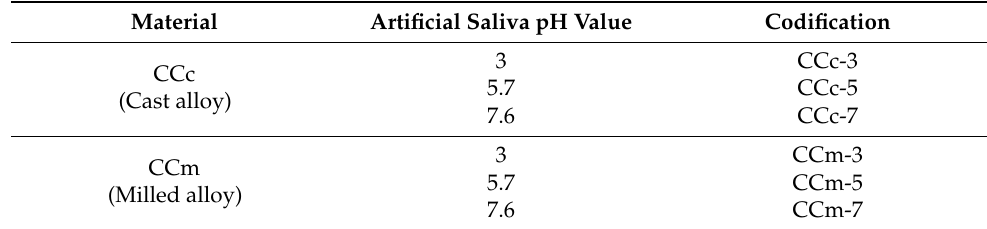
Table 4. Coding of experimental samples from corrosion tests.